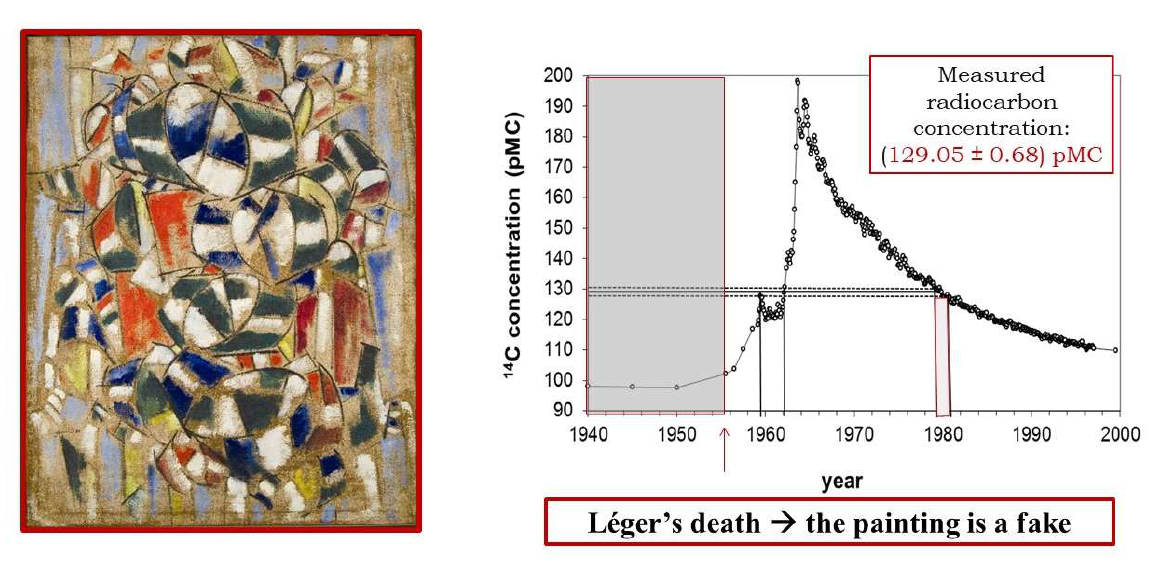
Fig. 4. The black curve represents the 14 C concentration increase until 1963-1965 due to nuclear test explosions. From the 14 C concentration, it appears obvious that the canvas was produced using cotton plants harvested in 1959, 1962, or 1979-80, I.e. after Fernand Léger’s death on August 17, 1955 in